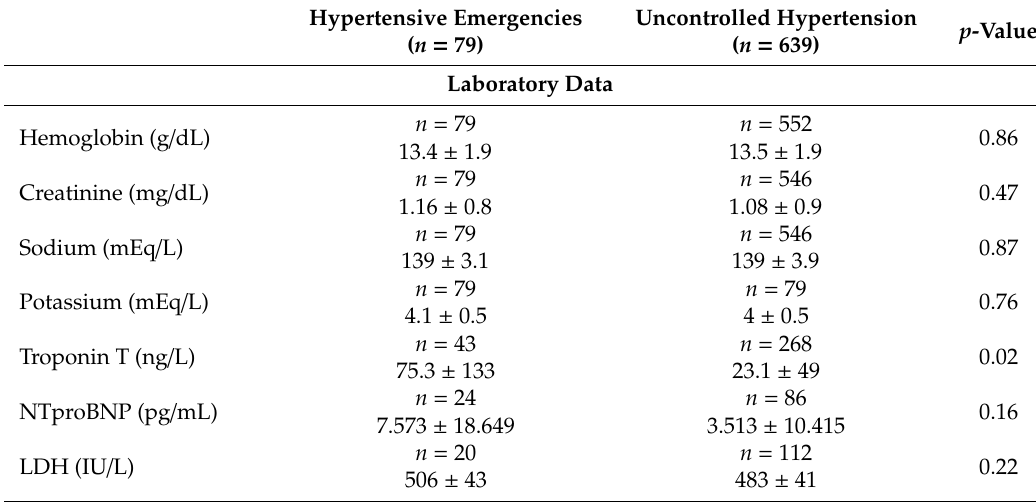
Table 3. Biochemical